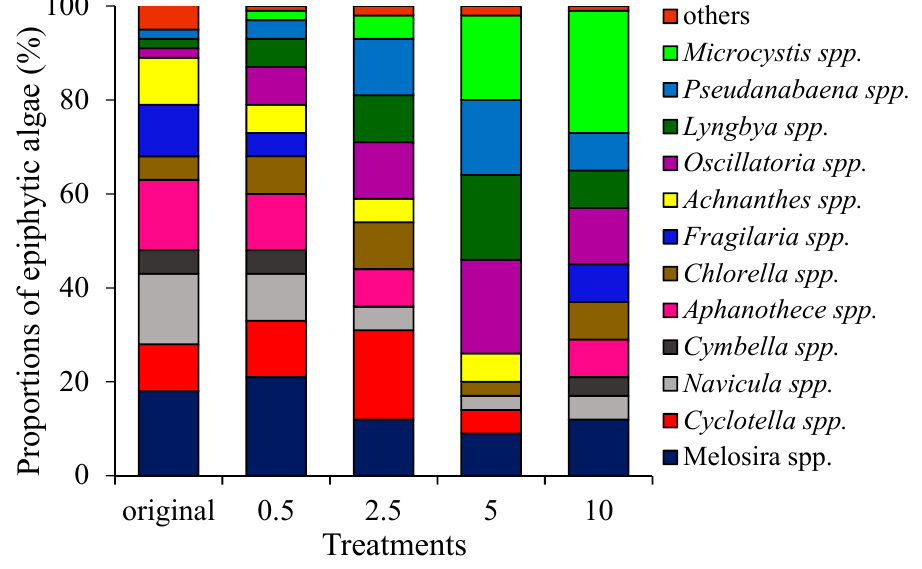
Figure 3. The main community composition of epiphytic algae of the original source and that after varied under different nitrate-N concentrations.